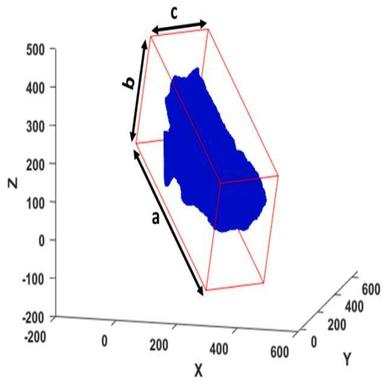
An example of a 3D particle (blue) and its minimum bounding box (red). a, b and c are the length of the sides of the cuboid; a is the longest, b is the medium and c is the shortest side length. (For interpretation of the references to color in this figure legend, the reader is referred to the web version of this article.)